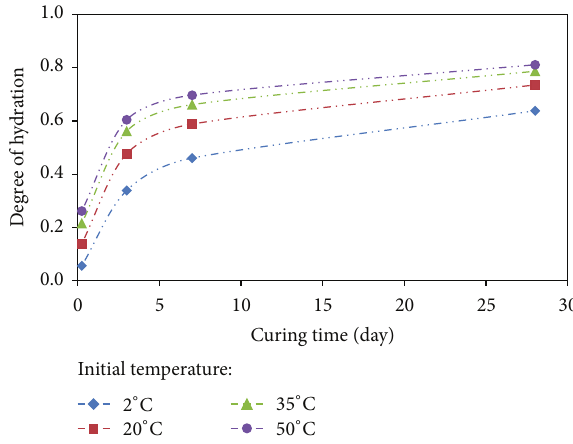
Figure 9: Effect of curing time on the evolution of the calculated degree of hydration at various initial